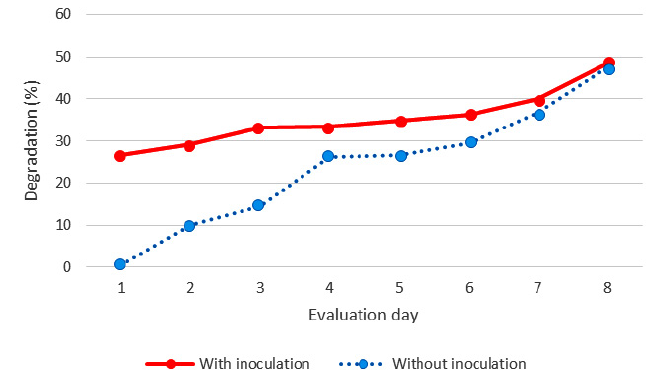
Fig. 1. 2,4-D degradation in presence and absence of bacterial consortium